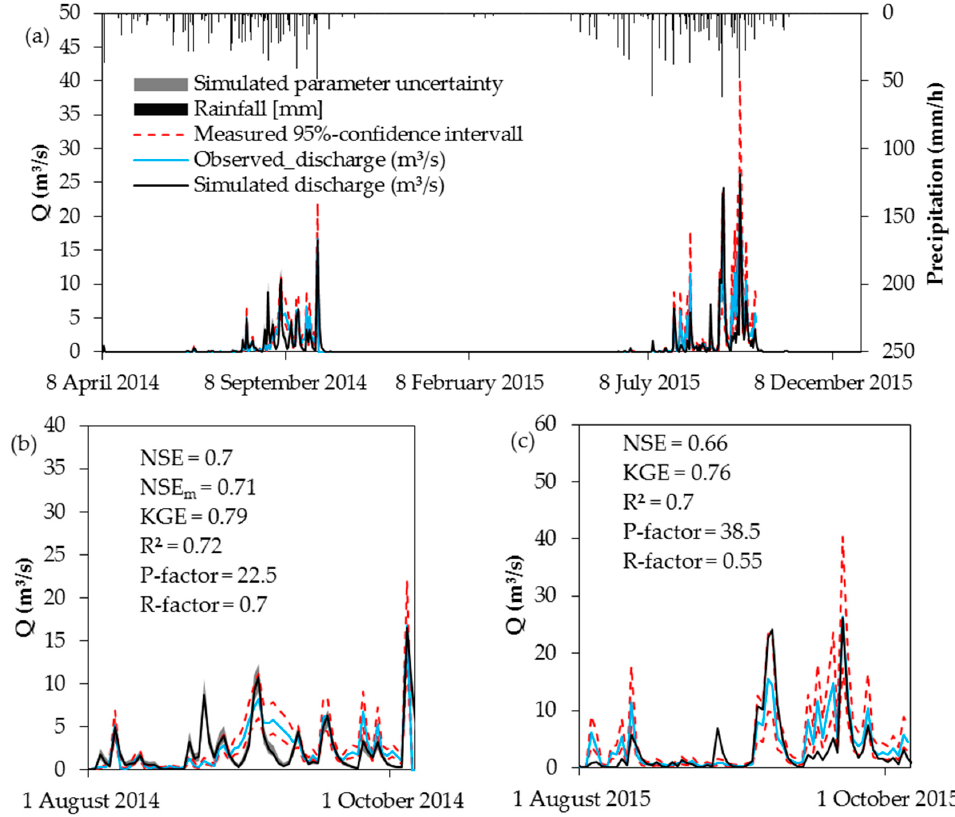
Figure 4. Observed and simulated daily discharge (Q) over the calibration and validation period ( a ); and over a selected period for the calibration ( b ); and validation ( c ) period. The measured 95%-confidence interval is given for both periods, simulated parameter uncertainty only for the calibration year.